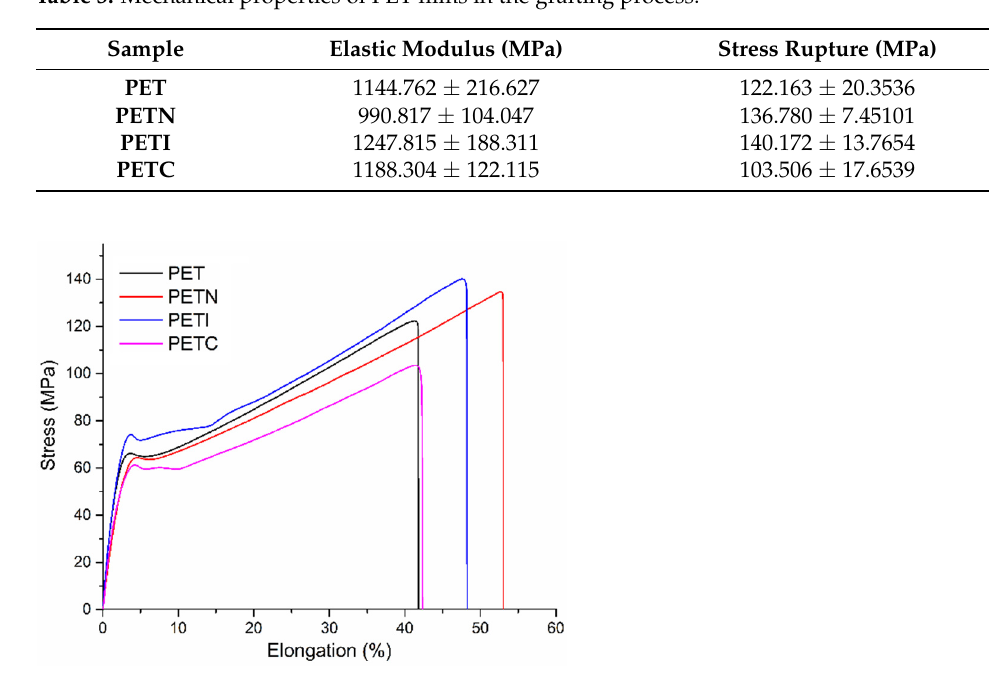
Figure 7. Tensile stress–strain graph of PET films in the process of grafting chitosan polymer chains. Table 3. Mechanical properties of PET films in the grafting